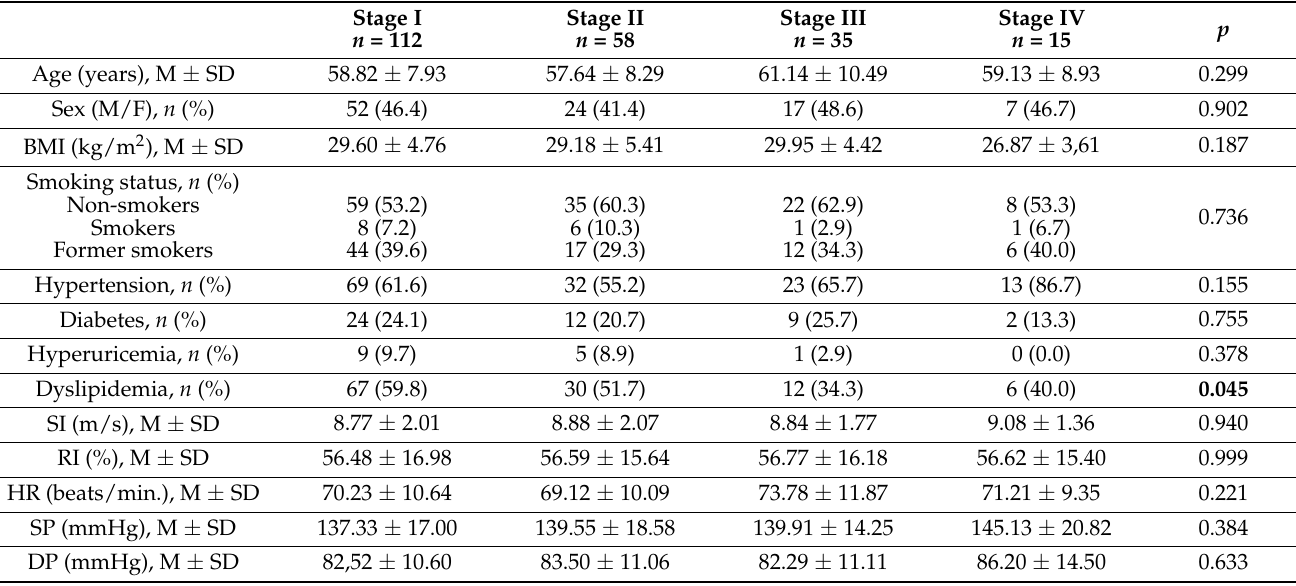
Table 2. Comparisons between the subgroups of COVID-19 convalescents depending on the severity of the acute phase of the disease (i.e., stage I, stage II, stage III, stage